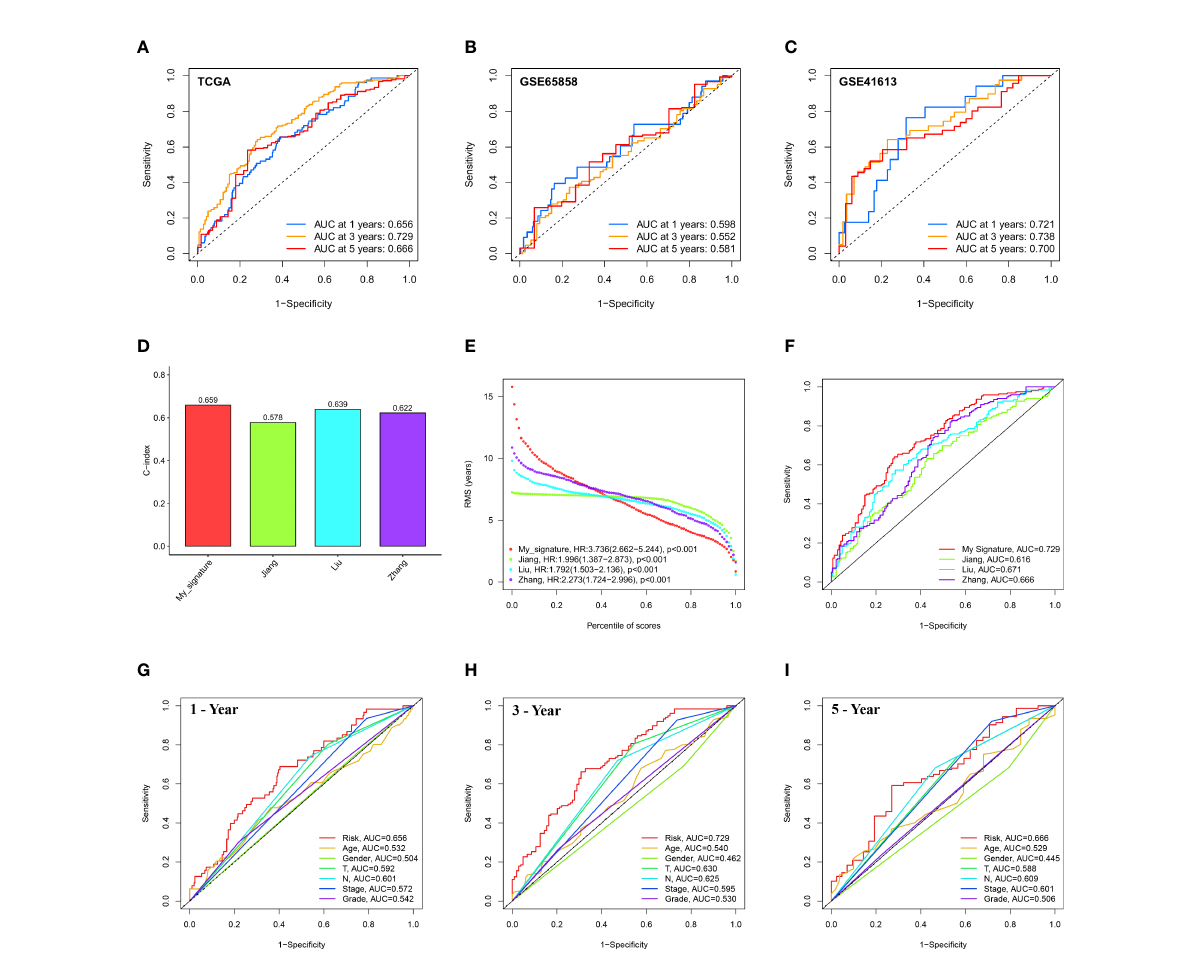
FIGURE 5 Evaluation and comparison of 12-ion-channel-gene model. ROC curve analysis of the 12-ion-channel-gene signature of the 1, 3, and 5 years in the TCGA (A) , GSE65858, and (B) GSE41613 datasets (C) . Comparison of our prognostic risk model with Jiang's, Liu's, and Zhang's in the TCGA cohort, (D) the C-indexes, (E) restricted mean survival time curves, (F) ROC curves. ROC curve analysis of risk score and the other six clinical features at 1 (G) , 3 (H) , and 5 years (I)